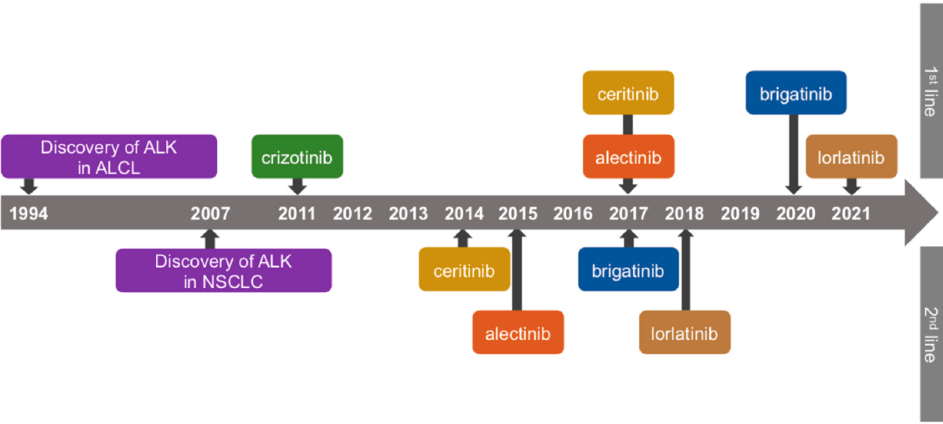
Figure 1. Timeline of discovery of ALK and US FDA approval of ALK-TKIs. ALCL: anaplastic large cell lymphoma, NSCLC: non-small cell lung cancer